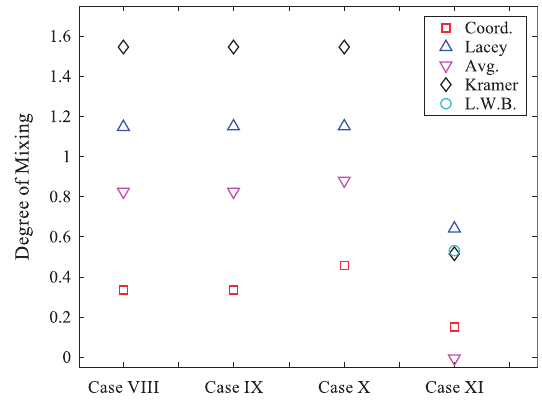
Fig. 9 The degree of mixing for different mixing indices for series C. The cell size is n =